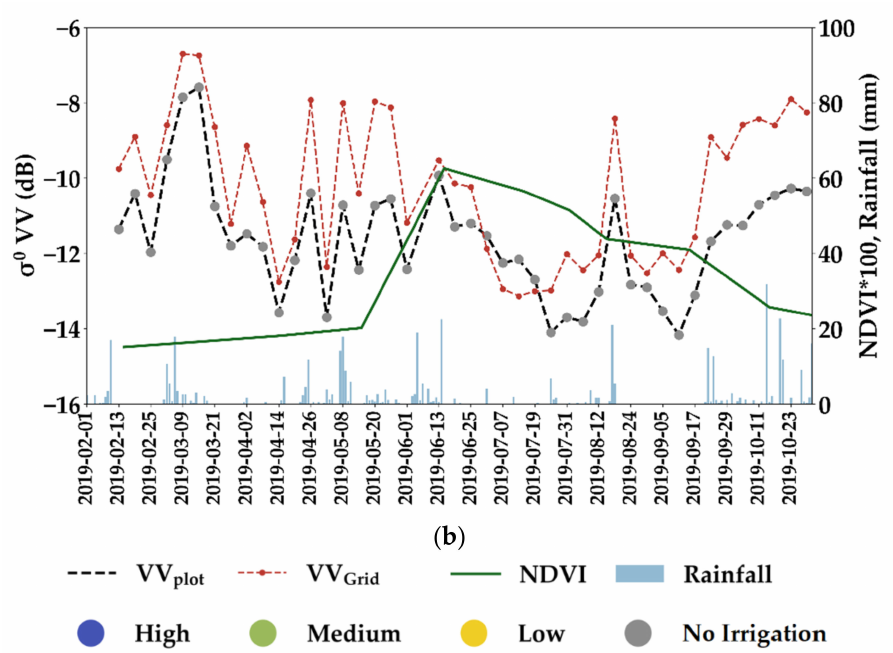
Figure 5. Example of σ 0 p σ 0 and NDVI temporal profiles for ( a ) irrigated maize plot and ( b ) non- G irrigated maize plots for the year 2019. Black arrows highlight the dates with detected irrigation events by the IEDM. Blue bars show the daily rainfall from the GPM